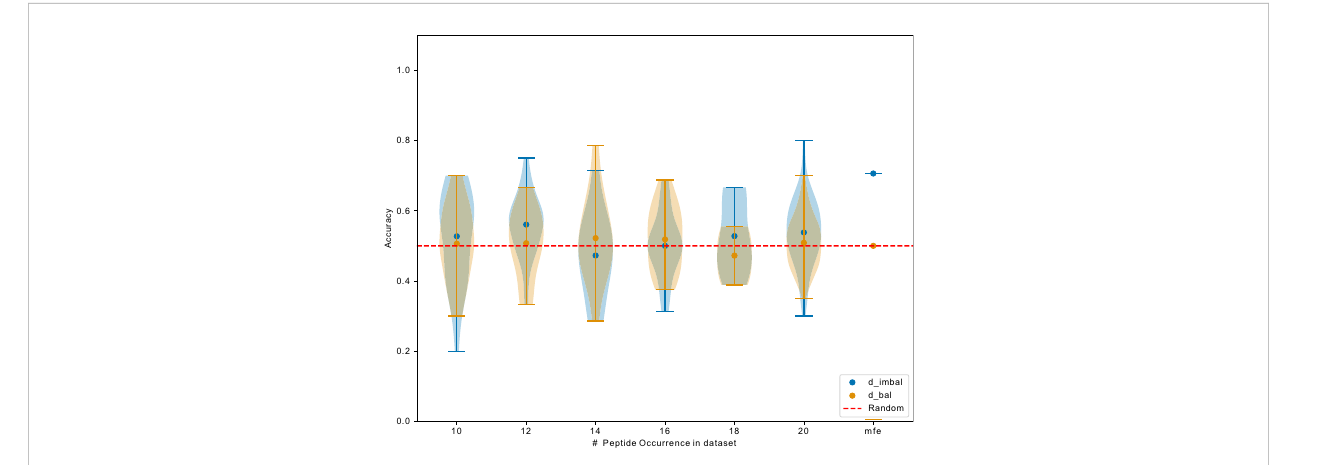
FIGURE 7 Exemplary comparison of NetTCR-2.0 performance trained on d imbal and d bal . Data points indicate accuracy for models (trained on different datasets) testing on unique peptide with different occurrence. mfp: most frequent peptide 20 examples in d bal and 9476 examples in d imbal